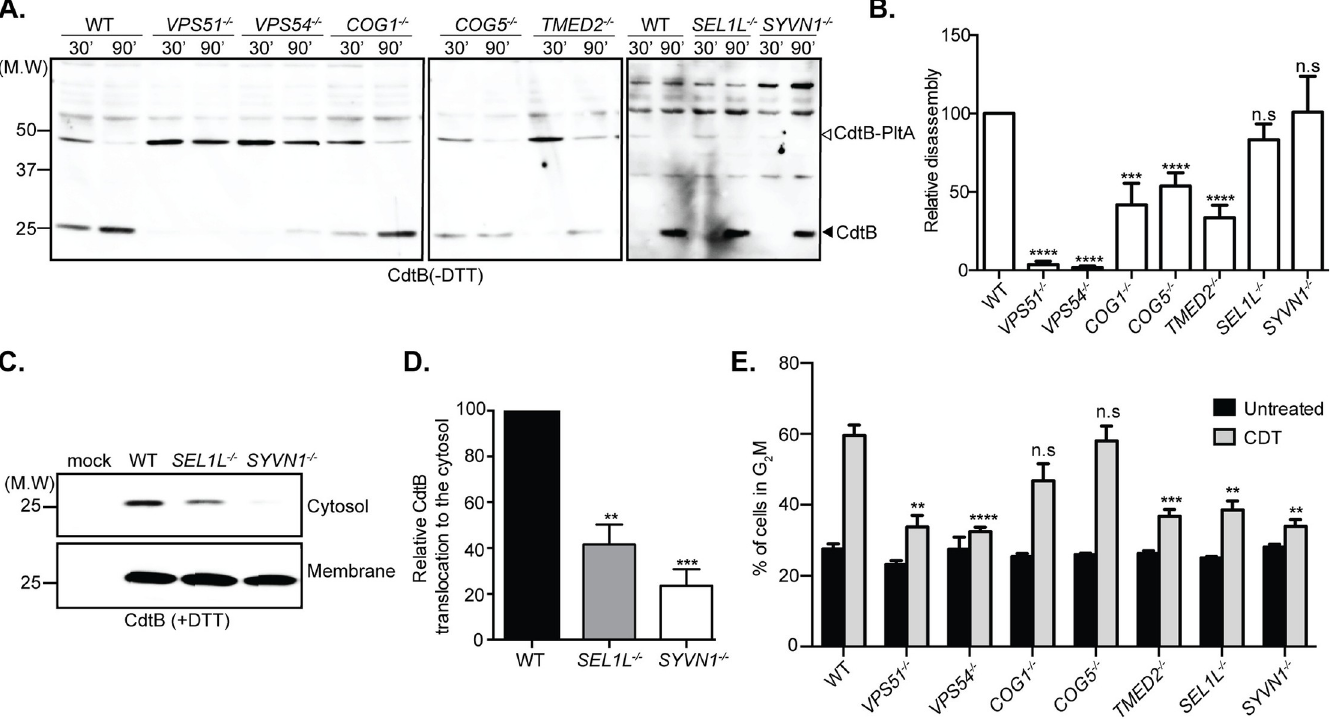
Fig 5. Characterization of typhoid toxin trafficking to the endoplasmic reticulum and cytosol in CRISPR/Cas9-edited cell lines. (A) Wild-type and knockout cells lines were treated with purified typhoid toxin and at the indicated time points, typhoid toxin was recovered from cell lysates by affinity chromatography and analyzed by western blot with an anti toxin antibody as indicated in Materials and Methods. (B) Proportion of typhoid toxin that underwent disassembly as a consequence of its arrival to the ER determined as indicated in Materials and Methods. Values represent the mean ± SEM of 3 independent determinations. ���� p < 0.0001, ��� p < 0.001; n. s.: differences not statistically significant; two-tailed Student’s t-test. (C) Presence of typhoid toxin in the cytosolic fractions (after retro-translocation) in the indicated knockout cells. Cells were incubated with purified typhoid toxin and fractionated to examine the amount of typhoid toxin in the cytosolic fractions by western blot analysis. (D) Quantification of the relative amount of typhoid toxin in the cytosolic fraction. Values represent the mean ± SEM of three independent experiments. ��� p < 0.001, and �� p < 0.01; two-tailed Student’s t-test. (E). Toxicity of cytolethal distending toxin in defective cell lines. The parent wild type (WT) and the indicated knockout cell lines were treated with 5 μ g of C . jejuni CDT for 48 hr and subjected to flow cytometric cell cycle analysis. Values are the mean ± SD of five independent experiments. ��� p < 0.001, �� p < 0.01; n. s.: differences not statistically significant; two-tailed Student’s t-test.